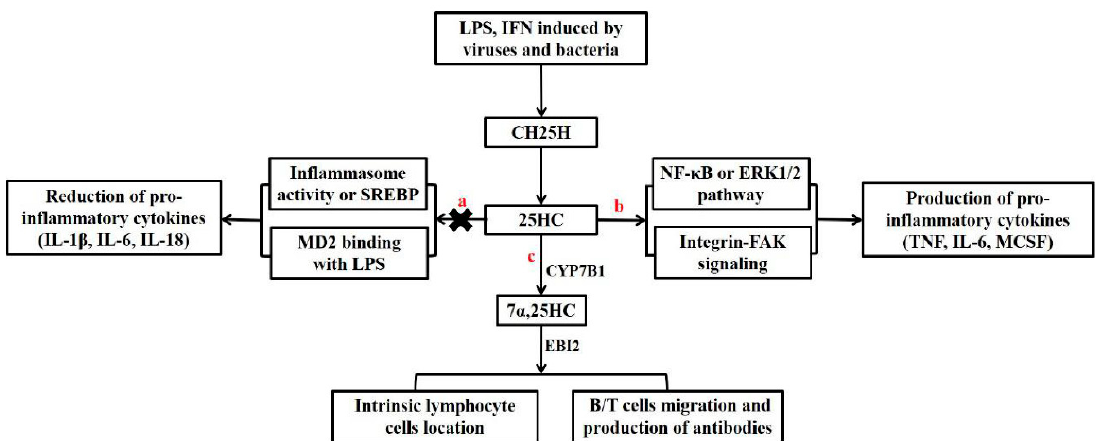
Figure 2. Regulation of inflammation, innate immunity, and adaptive immunity by CH25H and 25HC. The expression of CH25H, which encodes cholesterol 25-hydroxylase, and the generation of 25HC were enhanced by pathogen-induced interferon (IFN) or lipopolysaccharide (LPS). a, 25HC has anti-inflammatory e ff ects by suppressing SREBP or inflammasome activity and interacting with myeloid di ff erentiation protein 2 (MD2) to prevent the LPS-induced activation of Akt and the NF- κ B signaling pathway. b, 25HC acts as an inflammatory amplifier to promote the production of pro-inflammatory cytokines by activating the NF- κ B and ERK1 / 2 pathways. c, Both innate immune cells and adaptive immune cells can be regulated by 7 α -25HC through its ligand-G protein coupling receptor Epstein-Barr virus-induced gene 2